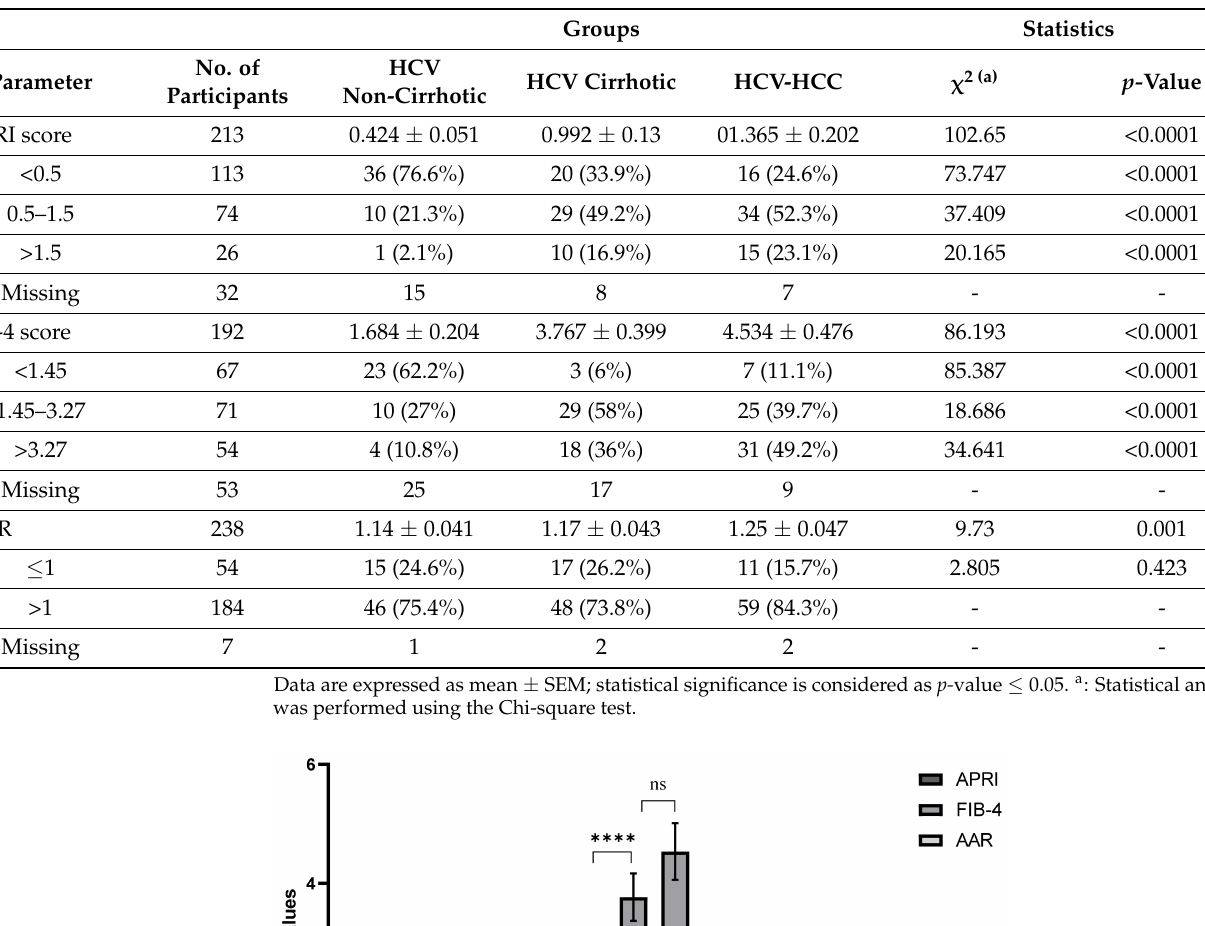
Table 2. Non-invasive indices for determination of fibrosis and cirrhosis degrees.